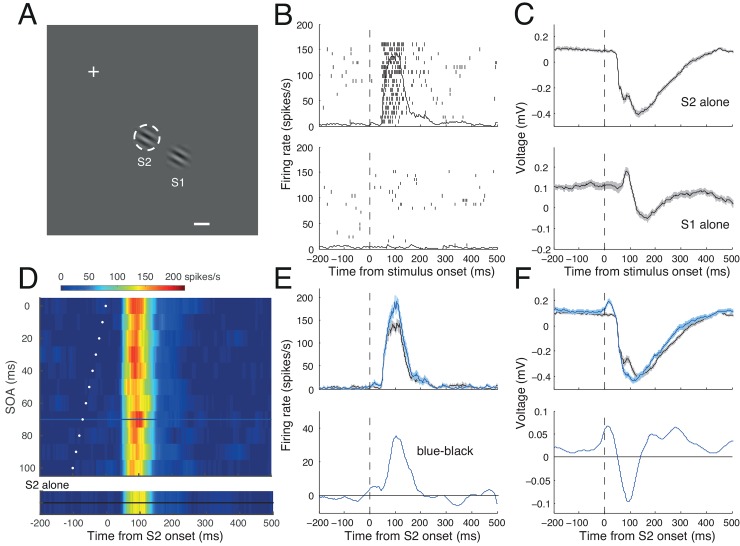
Spike and LFP activity of a representative cell.
A. Spatial layout of stimulus configuration: the cross marks the fixation target; the dashed white circle(invisible to the animal) shows the boundary of the RF; the calibration bar indicates 1°. The RF was centered 3.3° right and 4.2° down. Two Gabor stimuli, one at the RF (S2), and the other in the RF surround (S1) are shown. B, C. Raster and spike density plots (B) and mean LFP traces (C) in response to S2 alone (upper) and S1 alone (lower), aligned at their onset times (dashed vertical line). Shadings in C indicate ±2 SE. Y-axis indicates spike density in spikes/s in B, and LFP amplitude in mV in C. Note that a robust LFP change was recorded in response to S1 alone, while the cell did not discharge spikes. D. SOA time plot for response modulation during trials with S1-S2 sequence stimuli, showing spike activity as a function of SOA and time, aligned at S2 onset. Activity is coded by color, as indicated by the calibration bar at top. White dots indicate the time of S1 onset for each SOA condition. The spike density for the S2-alone condition is given in a separate color map at bottom for comparison. Note that depending on SOA, spike density varied considerably in terms of magnitude and time course. Spike density for an SOA of 70 ms is indicated by the blue horizontal line, whereas the reference density for S2 alone (at bottom) is indicated by the horizontal black line; the time courses of both are shown in the upper panel of E with the same color coding. E, F. Upper: Spike (E) and LFP activity (F) in response to S1-S2 sequence stimuli with an SOA of 70 ms (blue), aligned at the time of S2 onset (dashed vertical lines). In each panel, a black trace indicates the reference of the S2-alone condition. Shadings indicate ±2 SE. Lower: The magnitude of modulation (S1-S2 sequence minus S2-alone) in firing rate (E) or LFP (F) is plotted for the SOA of 70 ms.